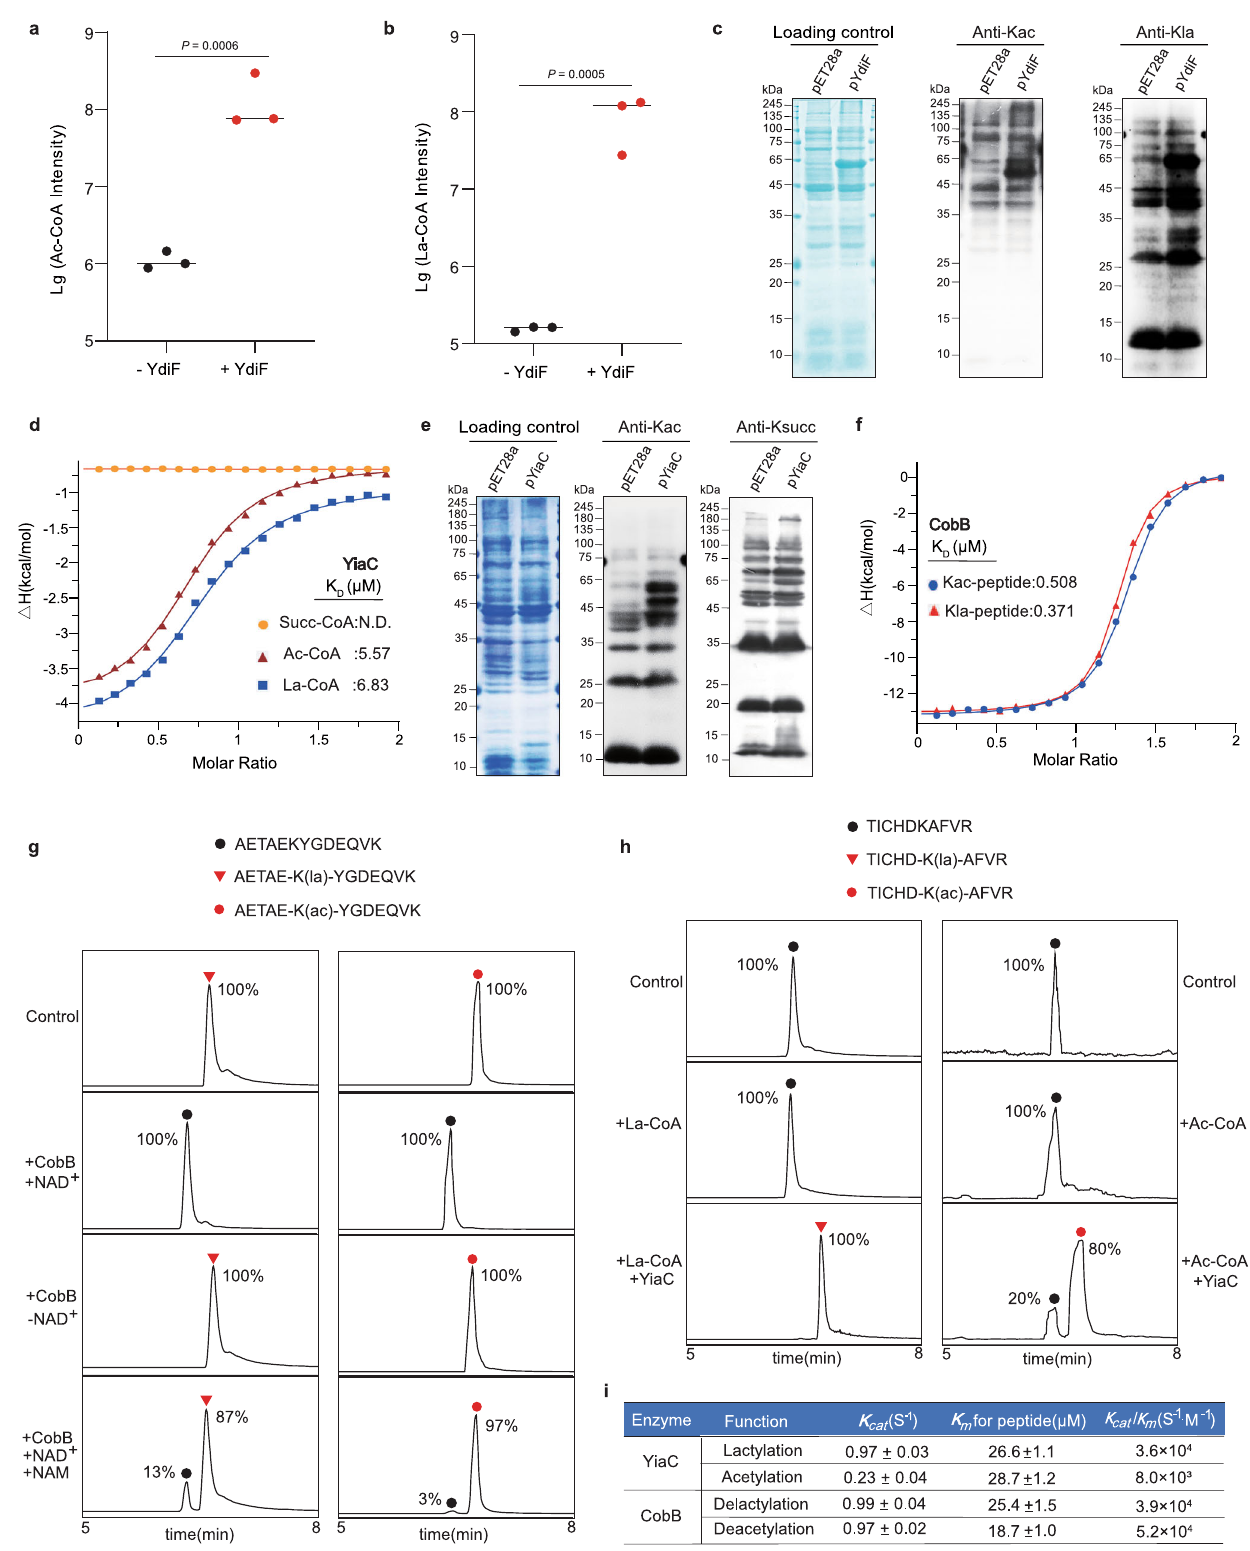
activity of CobB ( k cat = 0.99 ± 0.04 s − 1 , K m = 25.4 ± 1.5 μ M, k cat / K m = 3.9 × 10 4 s − 1. M − 1 ) is similar to the deacetylase activity ( k cat = 0.97 ± 0.02 s − 1 , K m = 18.7 ± 1.0 μ M, k cat / K m = 5.2 × 10 4 s − 1. M − 1 ). These results show the enzymatic kinetics characterization of YiaC for lactylation and CobB for